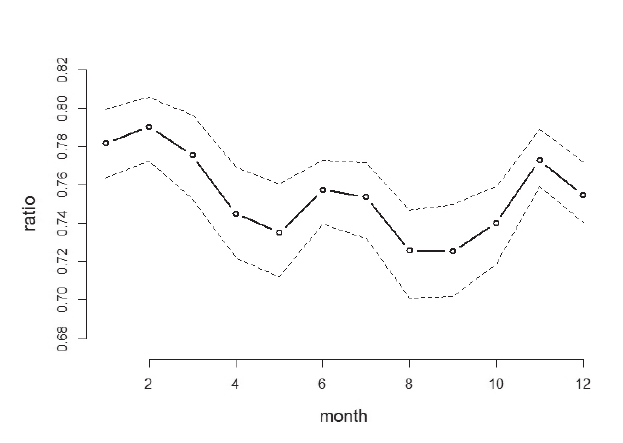
Figure 4. Serial correlation of the rent-to-price ratio Solid line indicates a median ratio of each month and dotted lines show 40th and 60th percentile ratios of the corresponding month.